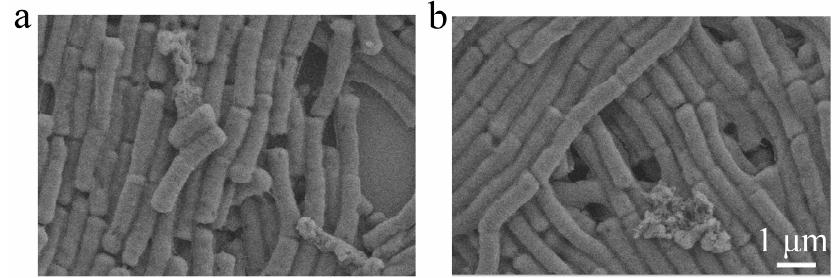
Figure 6. SEM of B. subtilis before ( a ) and after ( b ) being treated with an antibacterial patch.